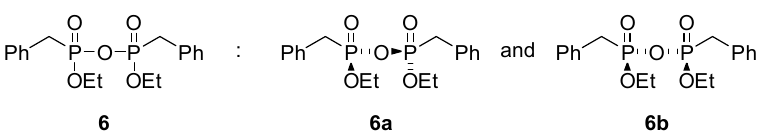
Figure 3. Structures of diastereomers 6a and 6b of diethyl dibenzylpyrophosphonate 6 which was identified in the reaction mixture.